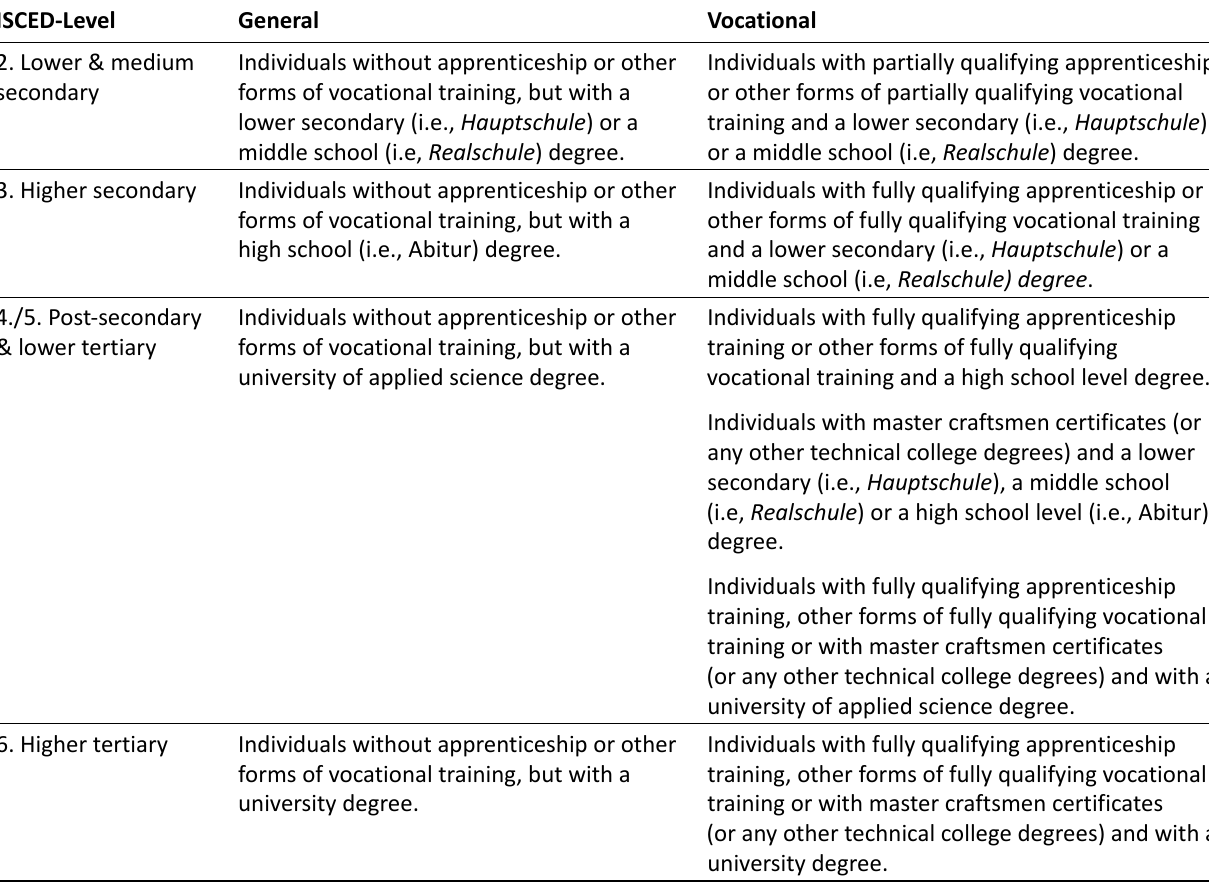
Table A2. Educational classification: General vs. vocational education.